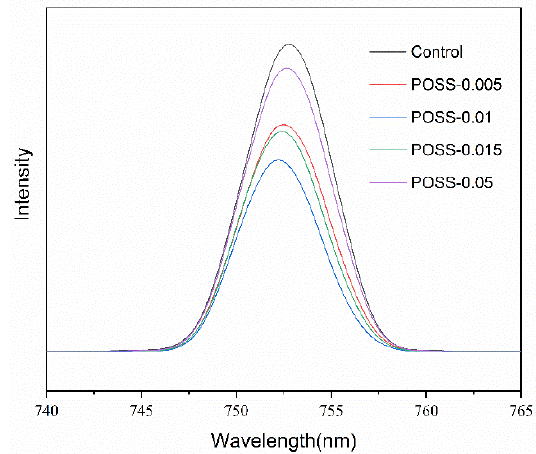
Figure 4. Drop images of the MAPbI 3 layers over the FTO/NiO X /POSS with various POSS contents and their corresponding contact angle: ( a ) control; ( b ) POSS-0.005; ( c ) POSS-0.01; ( d ) POSS-0.015; and ( e ) POSS-0.05.